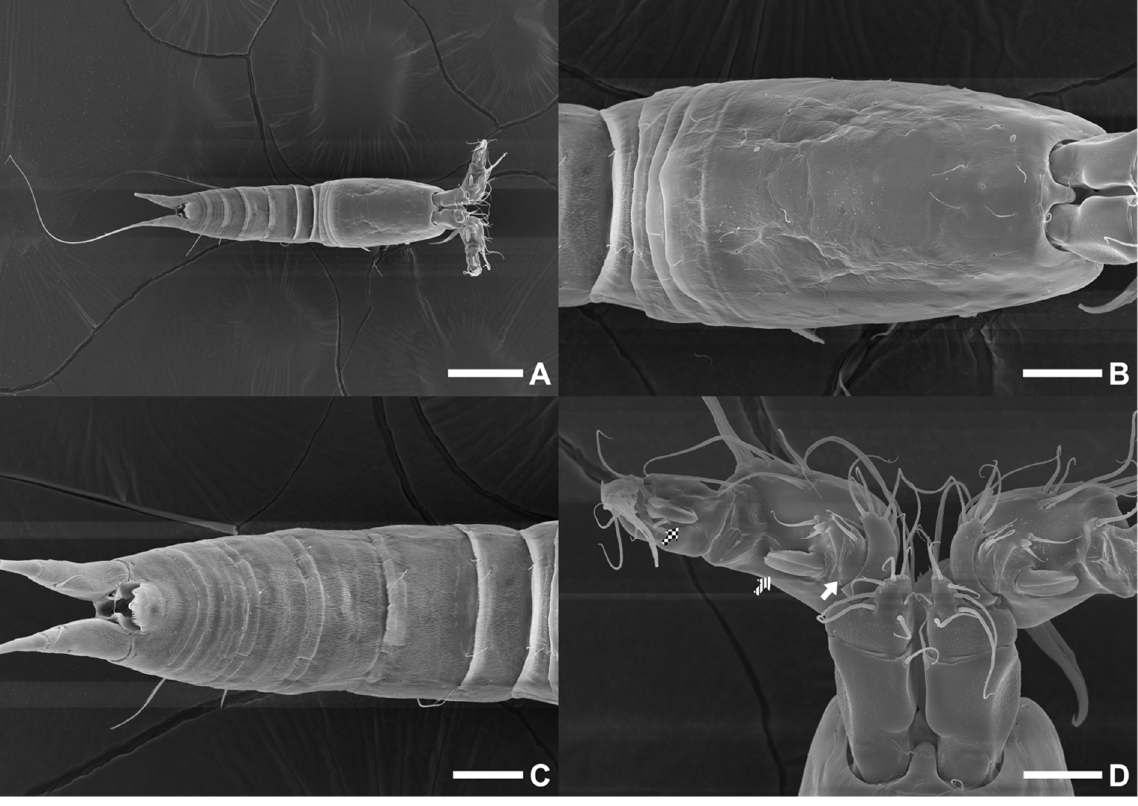
Figure 31. Scanning electron microscopy images of Phyllopodopsyllus similis sp. nov. male (paratype 22) in dorsal view: ( A ) habitus; ( B ) prosome; ( C ) urosome; ( D ) antennule. Scale bars: ( A ) 100 µm; ( B , C ) 30 µm; ( D ) 20 µm.